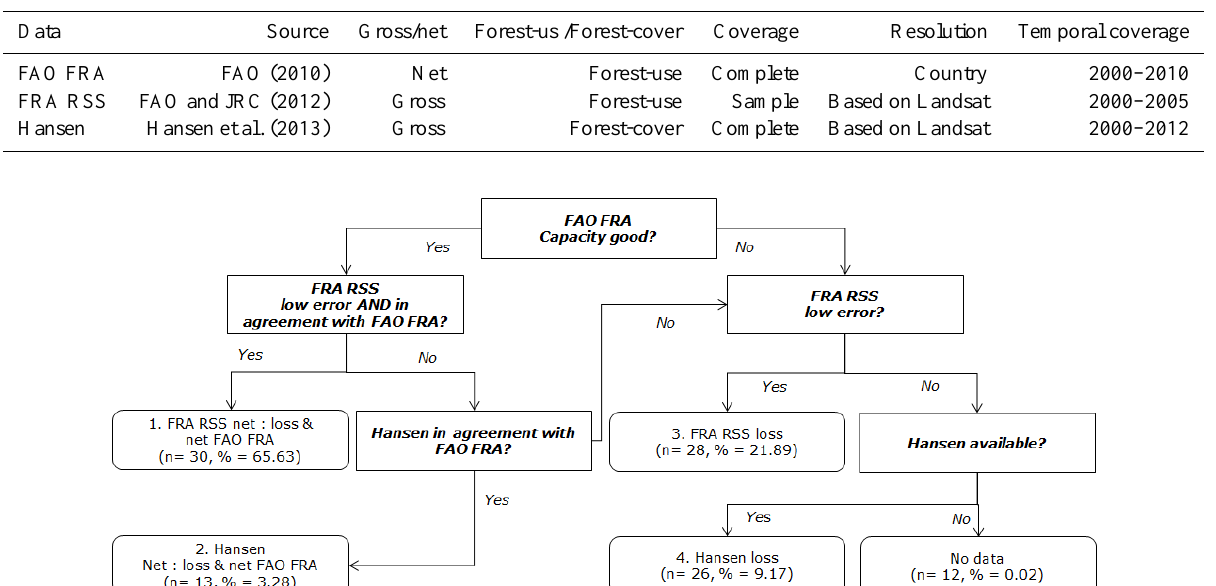
Table 2. Description of data sources used to derive deforestation at the national level.